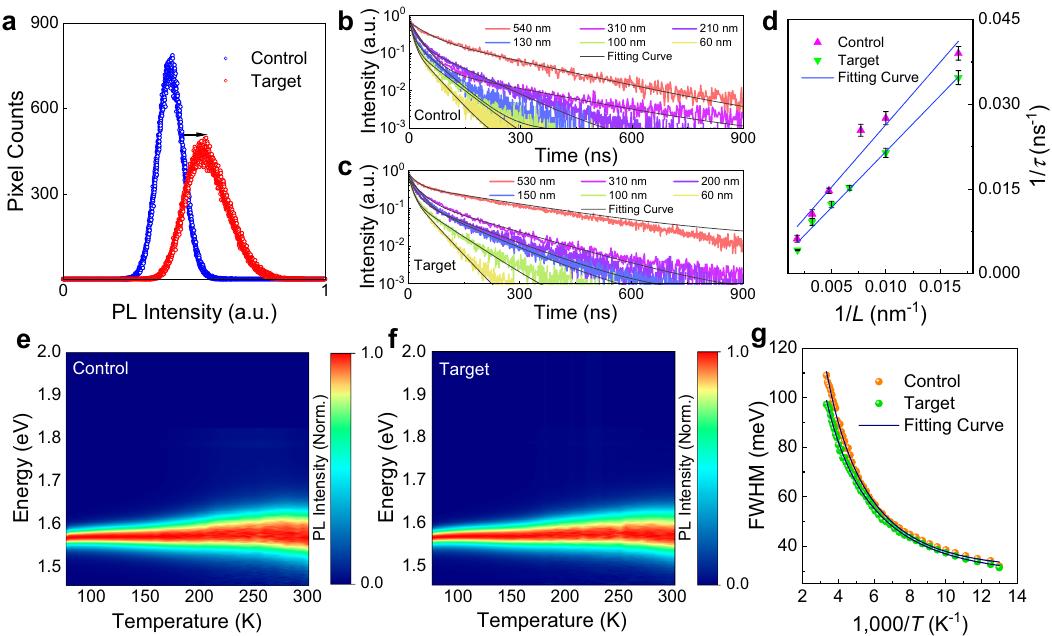
Fig. 4 Photoluminescence and electron – phonon coupling. a Photoluminescence (PL) emission intensity distribution. b , c Time-resolved photoluminescence (TRPL) decays of the control ( b ) and target ( c ) samples versus different thicknesses. d The dependence of carrier lifetime on fi lm thickness for the control and target samples and corresponding linear fi tting plots. The error bars are the standard error (SE). e , f PL intensities mapped with the emission energy and temperature for the control ( e ) and target ( f ) fi lms. g Temperature-dependent full width at half-maximum (FWHM) of PL emission peaks and the fi tting curves based on independent Boson